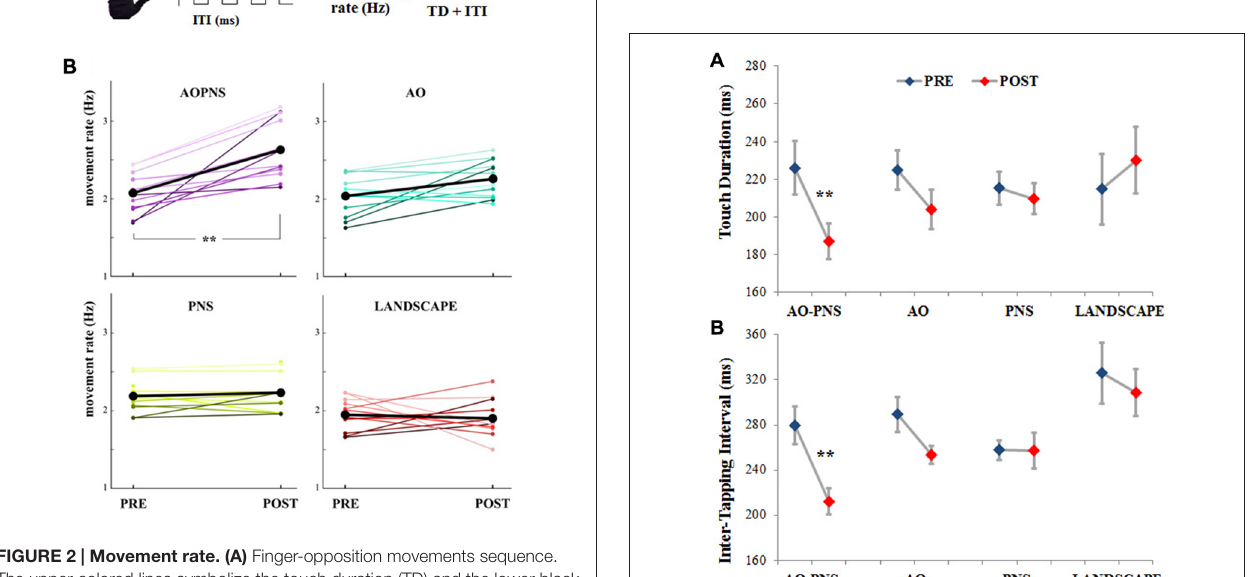
FIGURE 2 | Movement rate. (A) Finger-opposition movements sequence. The upper colored lines symbolize the touch duration (TD) and the lower black line stands for the interval between two consecutive finger opposition movement (inter-tapping interval, ITI). The colors code the finger. (B) Quantitative representation of the single-subject movement rate (Hz) in PRE and POST epochs (colored lines). Black lines show mean movement rate values for each experimental group: AO-PNS, AO, PNS and LANDSCAPE. **indicate significantly higher frequency in POST than PRE values ( p < 0.001).